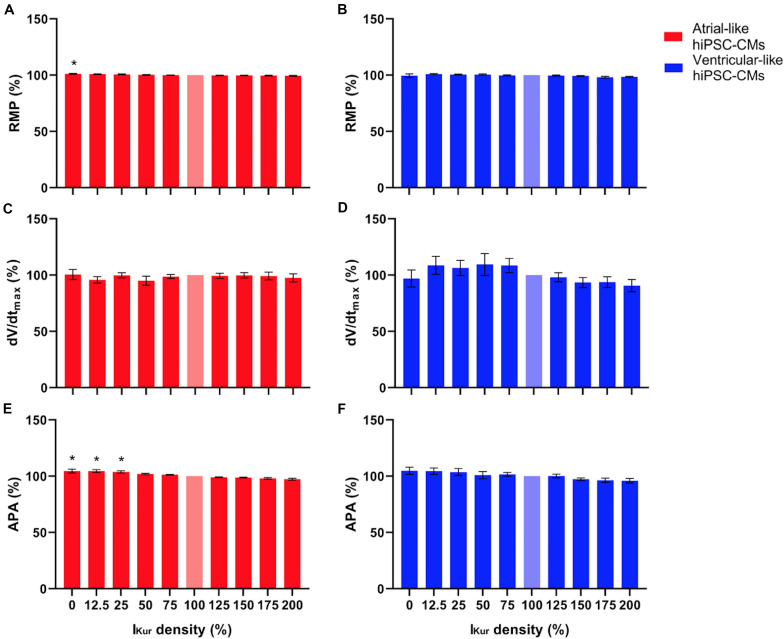
(A,B) RMP, (C,D) dV/dtmax, and (E,F) APA of atrial- and ventricular-like hiPSC-CMs (left and right panels, respectively) at virtual IKur densities ranging from 0 to 200%. AP parameters are expressed as percentage relative to their value at 100% IKur density (bleached bars). Data from 11 atrial- and 10 ventricular-like hiPSC-CMs. *P < 0.05.